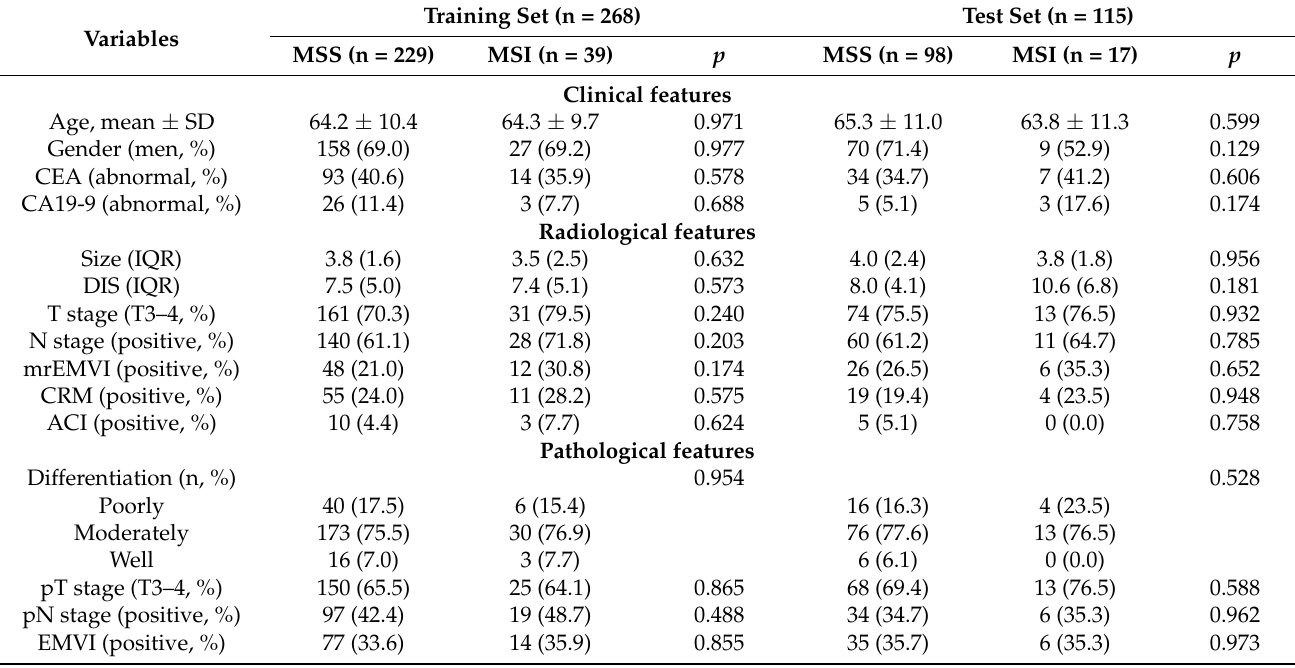
Table 2. Variables of patients between MSS and MSI in the training and test